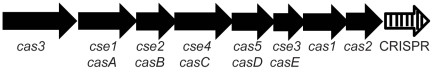
The CRISPR/cas gene locus in P. acnes J139.Shown is the gene order in strain J139 (locus tags: HMPREF9206_0746 (cas3) to HMPREF9206_0752 (cas1); cas2 has not been correctly annotated in the draft genome [GenBank: ADFS00000000]). The gene cluster is identical in all analyzed P. acnes genomes. The CRISPR loci are composed of 1–9 repeats and 1–8 spacers.